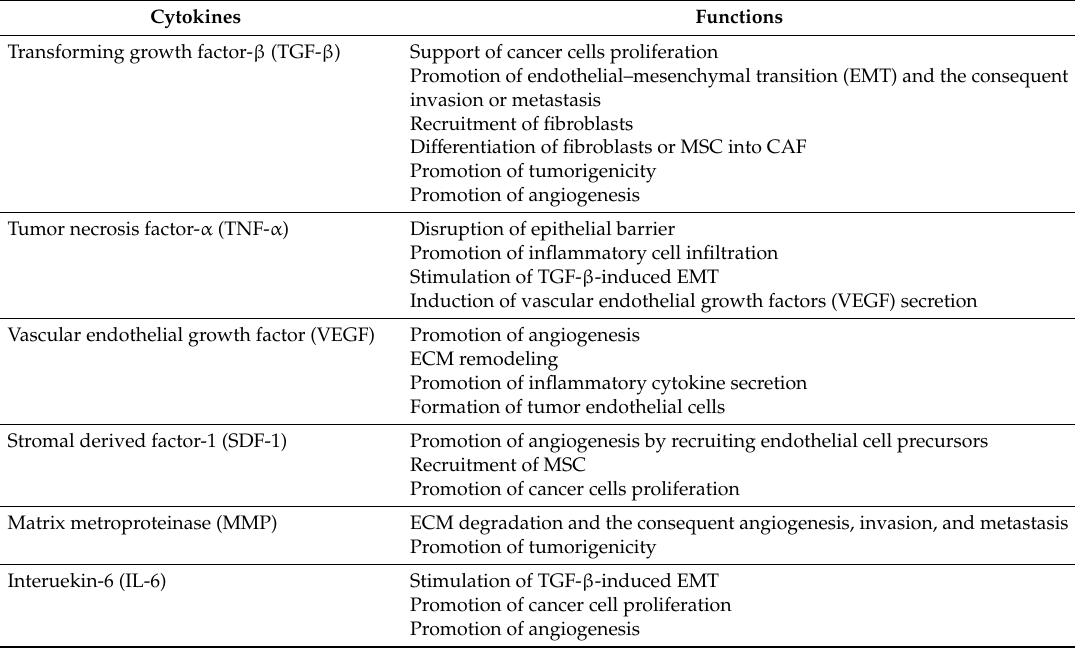
Table 2. Cytokines secreted in cancer environment and the biological